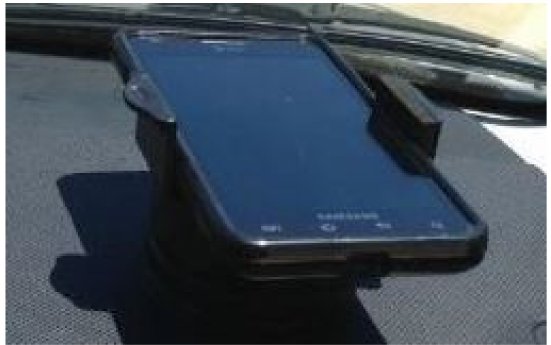
Figure 6. Mounting of the smartphone on the vehicle